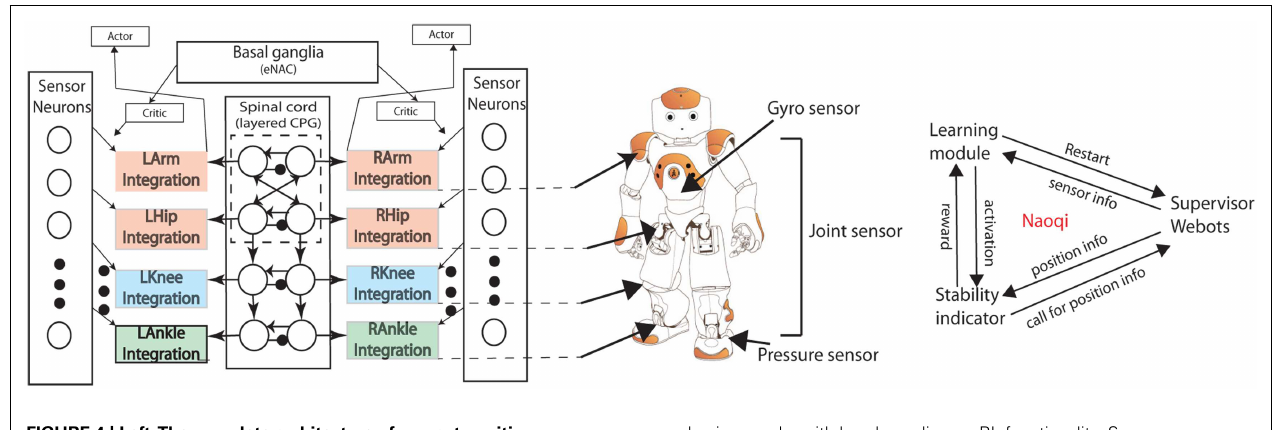
FIGURE 4 | Left:The complete architecture of cpg-actor-critic network. The integration with specific joint names represents the functions of motorneurons for each joint.The architecture abstractly represents the neurophysiological structure of the brainstem where the basal ganglia is in charge of RL, and the spinal cord is where the CPGs are located and motorneurons. Each layer of the three-layered architecture corresponds to different parts.The actor-critic learning